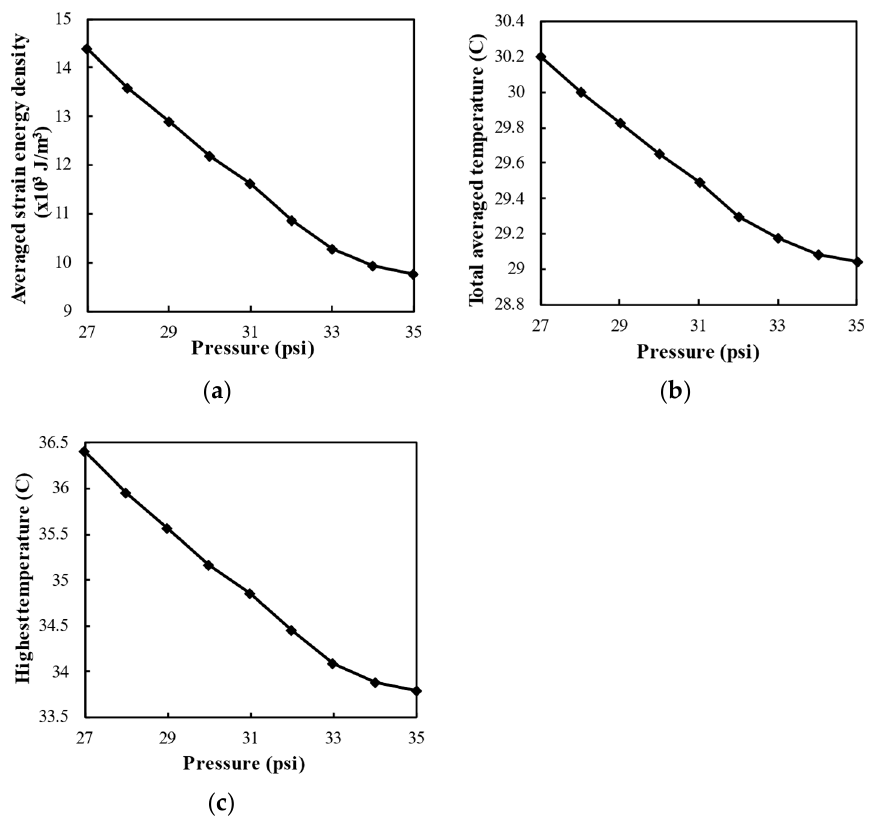
Figure 13. Variation in the three variables with varying inflated pressures and a loading of 6 kN for ( a ) strain energy density; ( b ) averaged temperature; and ( c ) highest temperature.